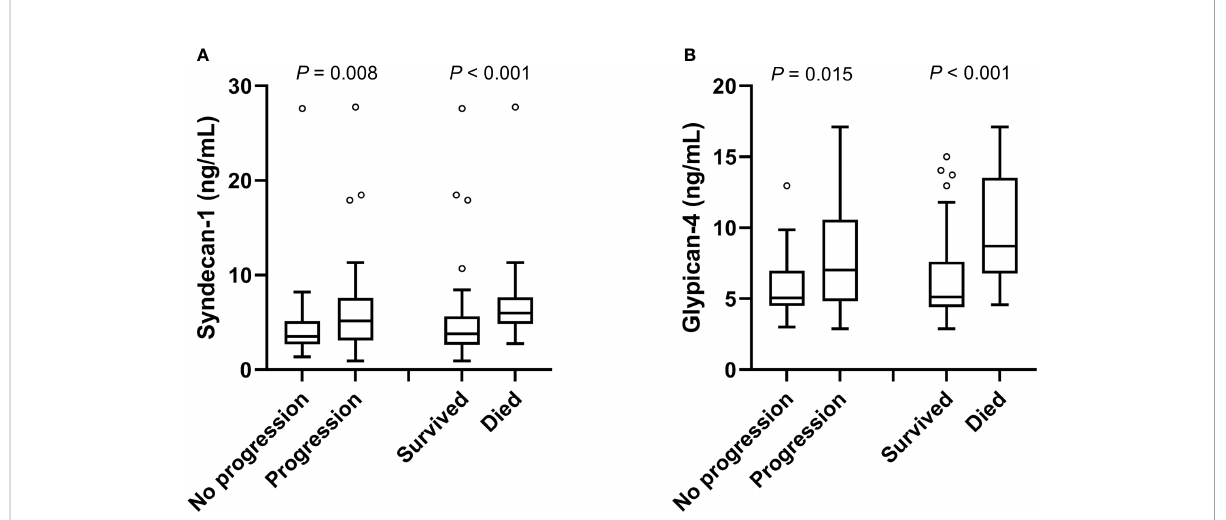
FIGURE 1 Plasma levels of SDC1 and GPC4 with respect to disease progression and mortality. Plasma levels of (A) SDC1 and (B) GPC4 with respect to disease progression and mortality are shown as box plots using the Tukey method for plotting the whiskers and outliers. P-values were calculated using the Mann-Whitney U